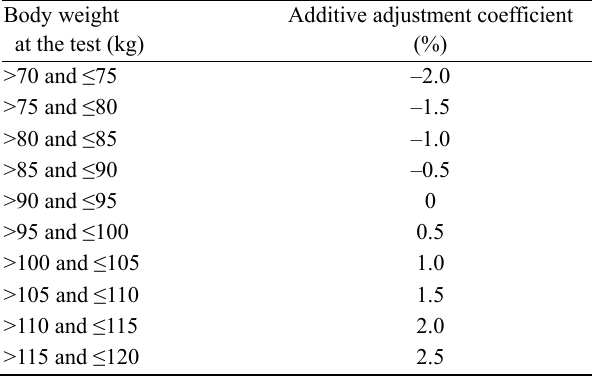
Table 1. Adjustment coefficients for retail cut